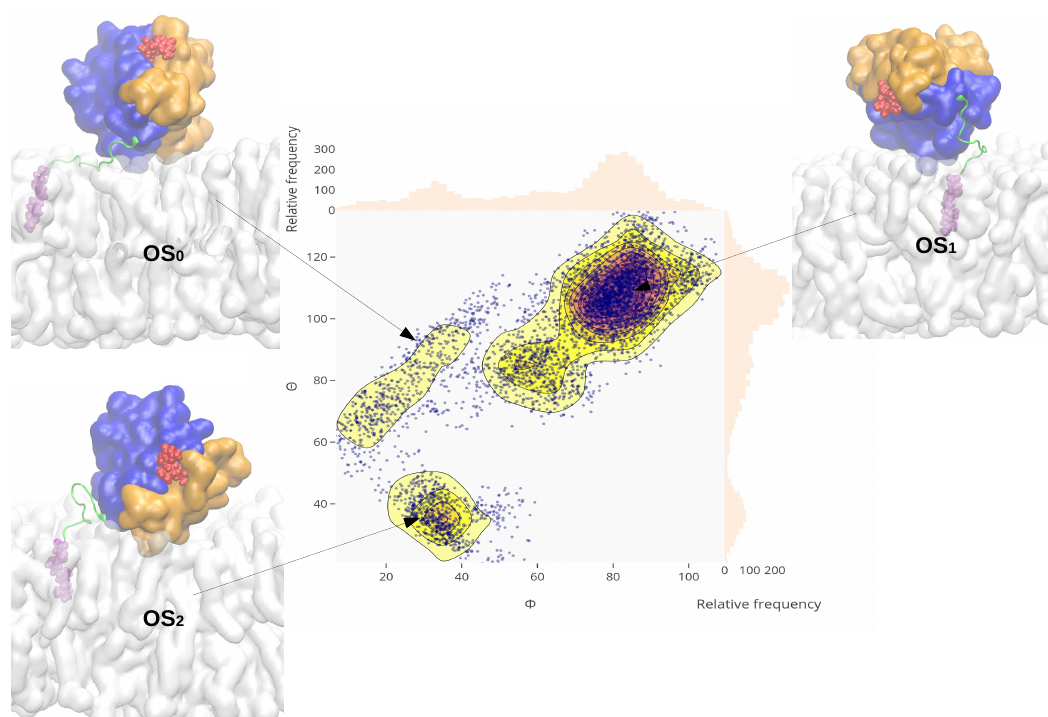
Figure 5. Reorientation of the oncogenic KRas-4B on the chol.-30% membrane. Density distribution of conformations projected onto a plane defined by the reaction coordinates Φ and Θ in degrees ( ◦ ). The relative frequency of each coordinate is shown on the right and upsides. The membrane bilayer is shown as a white surface. Lobe 1 is highlighted in orange, lobe 2 in blue, HVR backbone in green, GTP in red, and FAR in violet. Water and ions are not shown here for the sake of